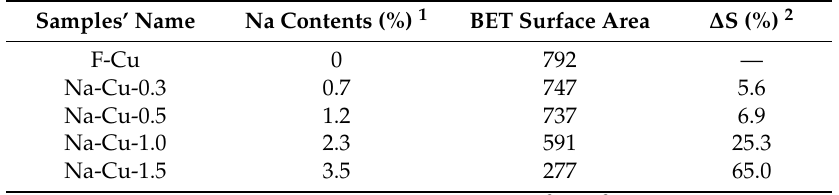
Table 1. Na contents and BET surface area of fresh and Na impregnated catalysts.